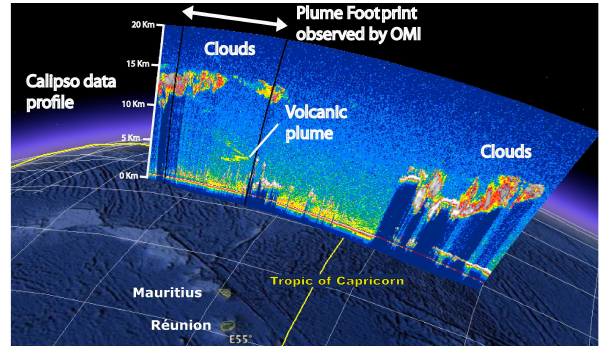
Fig. 4. Vertical CALIOP profile (532 nm Total Attenuated Backscattered) over Indian Ocean showing the volcanic Plume on 8 April 2007 at 21:00UTC (data obtained and modified from http: //www-calipso.larc.nasa.gov/products and Google